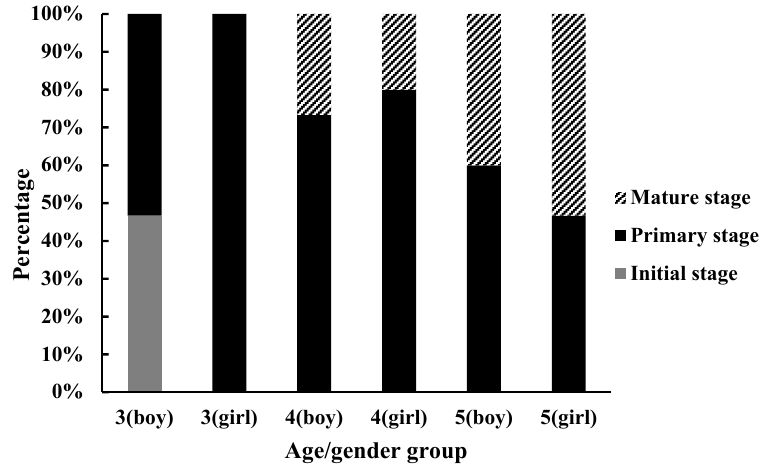
Figure 3. Proportion chart of motor development stages of children in different ages.